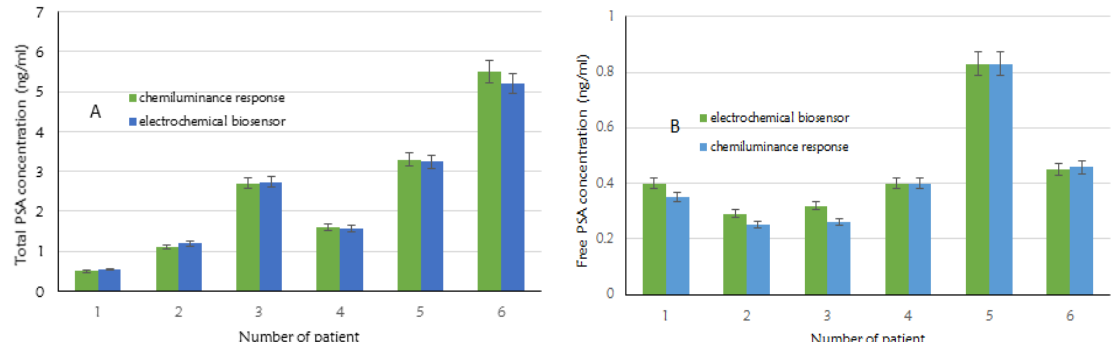
Figure 8: Comparison of (A) total and (B) free PSA concentration deduction results obtained by electrochemical sensor